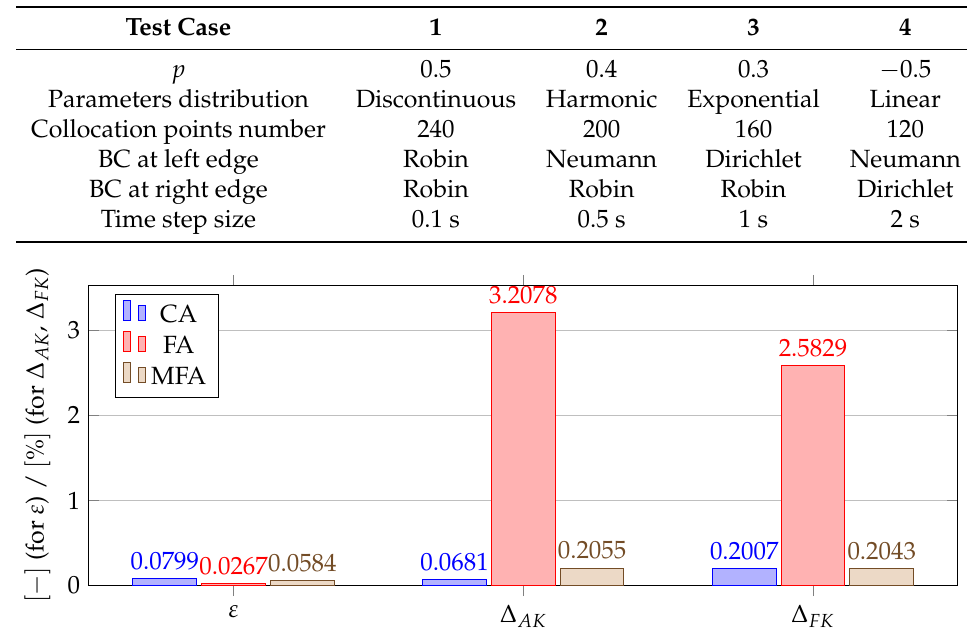
Table 1. Data of numerical examples.